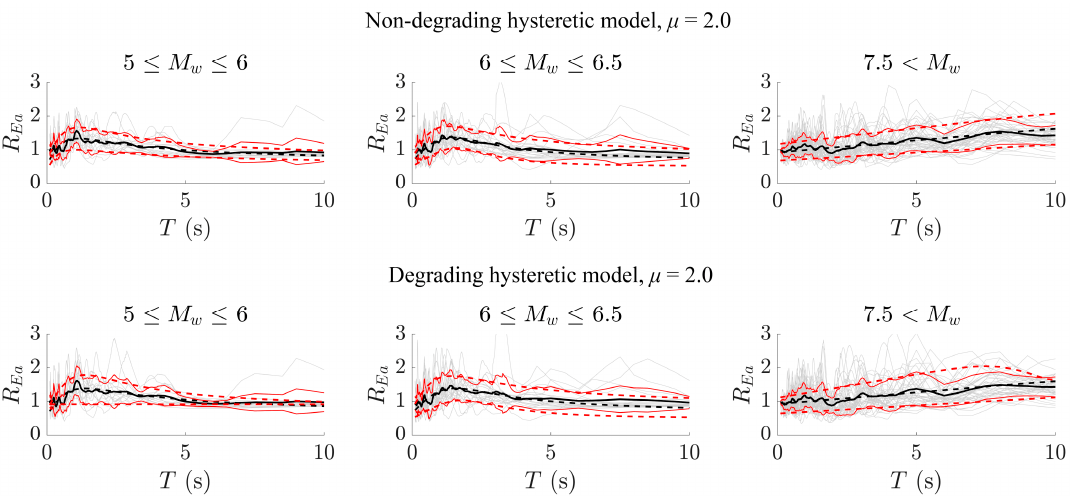
Figure 12. Comparison between calculated hysteretic energy reduction factor R Ha spectra (mean and mean plus/minus one standard deviation) and proposed approximation (thin solid line: single spectrum; thick solid line: calculated spectrum; thick dashed line: proposed approximation).